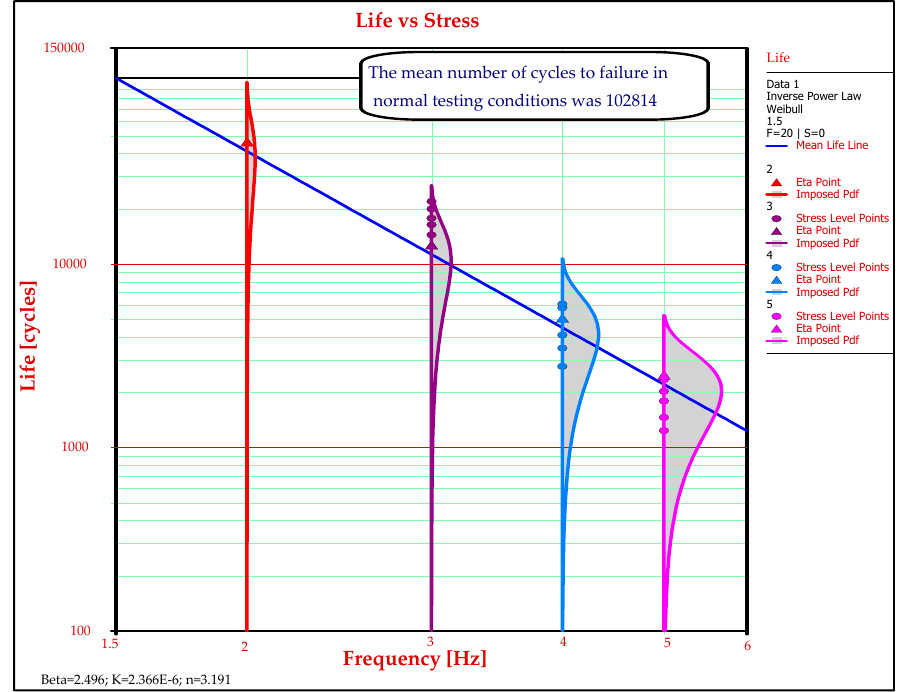
Figure 8. Determining the mean number of cycles to failure of the GFRP-foam sandwich specimens in normal testing conditions.